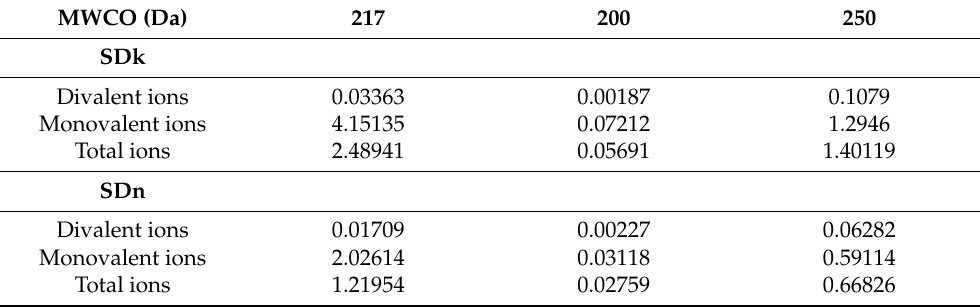
Table 6. Standard deviation dispersion values of all investigated